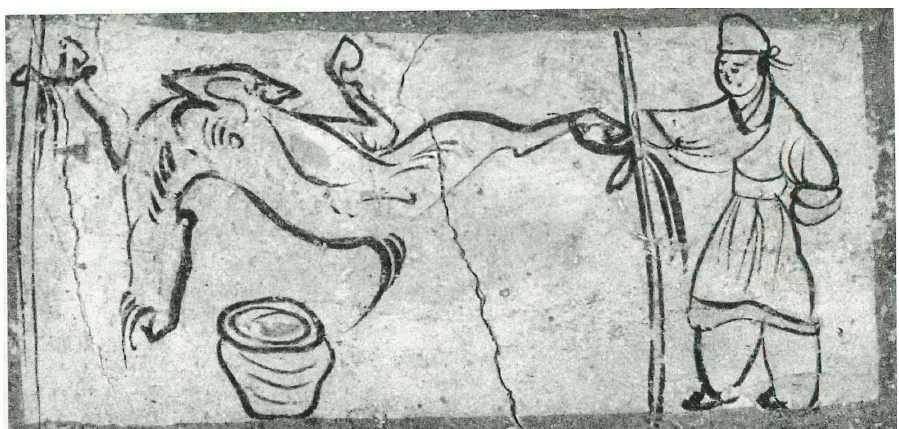
Figure 4. Goat being bled, east wall of front chamber, Xincheng M6, painting on brick, Wei‑Jin period (220–317), (Gansusheng Bowuguan et al. 1985, pl. 68.2). ©Wenwu Press. This figure published with permission of Wenwu Press and cannot be used or copied without their permission.